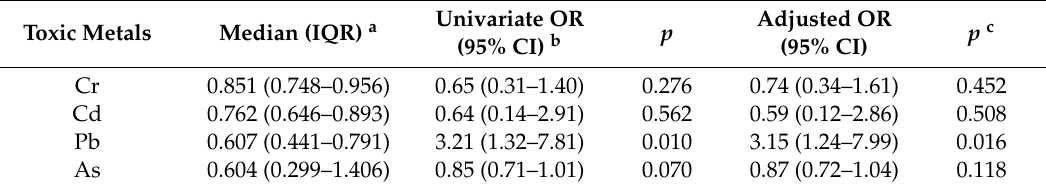
Table 3. Associations between the prevalence of schizophrenia and the concentrations of four toxic heavy metals (THMs).